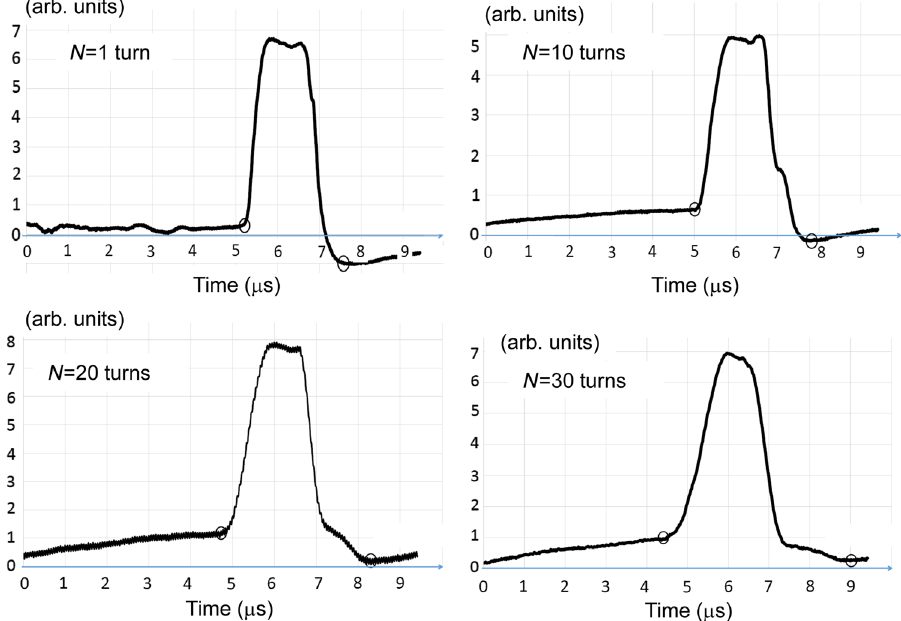
FIG. 8. Beam pulse signals for C 5 þ obtained by the electrostatic monitor. Circles denote the inflection points corresponding to both edges of a beam